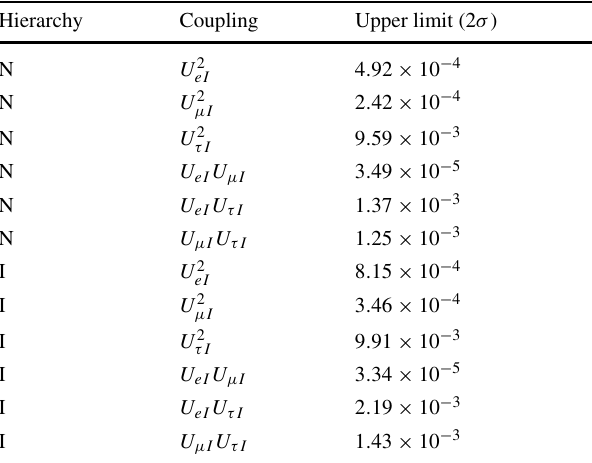
Table 7 Upper limits on U 2 α and U α I U β I within 2 σ in the high mass I region M I (cid:2) 80 GeV, for normal (N) and inverted (I)